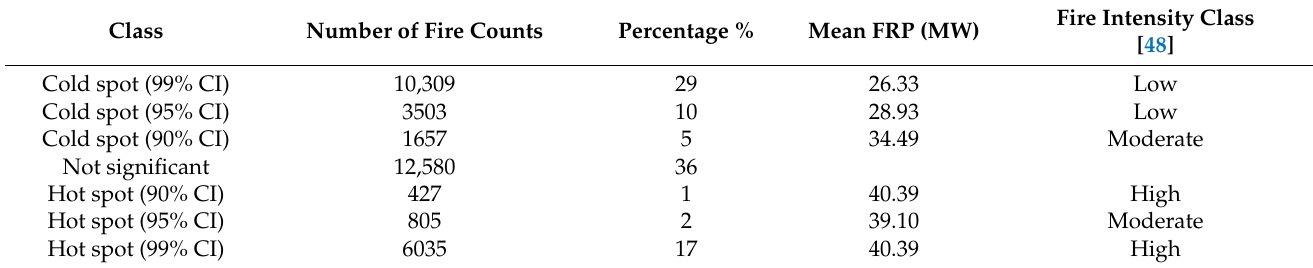
Table 3. Characteristics of fire intensity